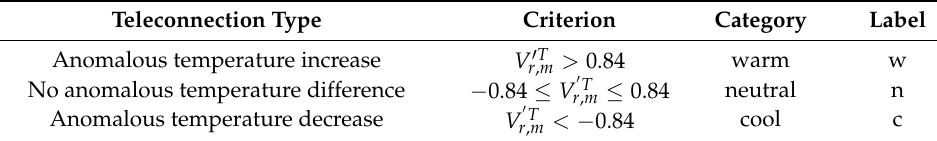
Table 2. The rule of transformation for temperature.